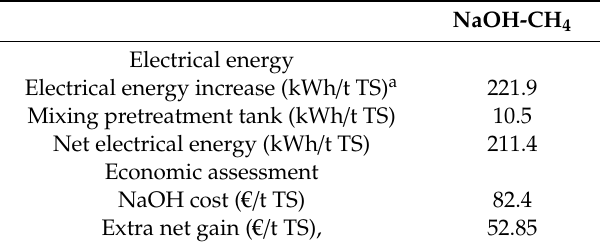
Table 5. Energy analysis and economical assessment for NaOH-CH 4